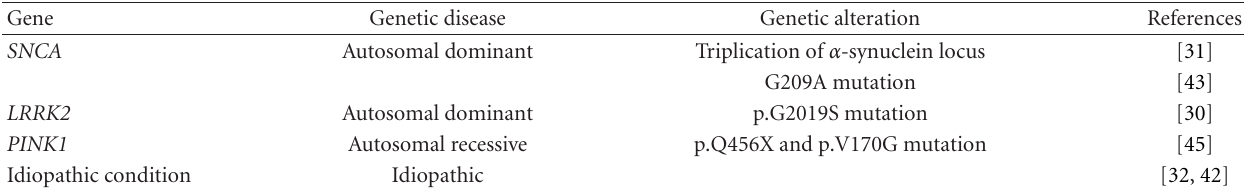
Table 1: Examples of in vitro models to study Parkinson’s disease derived from patient